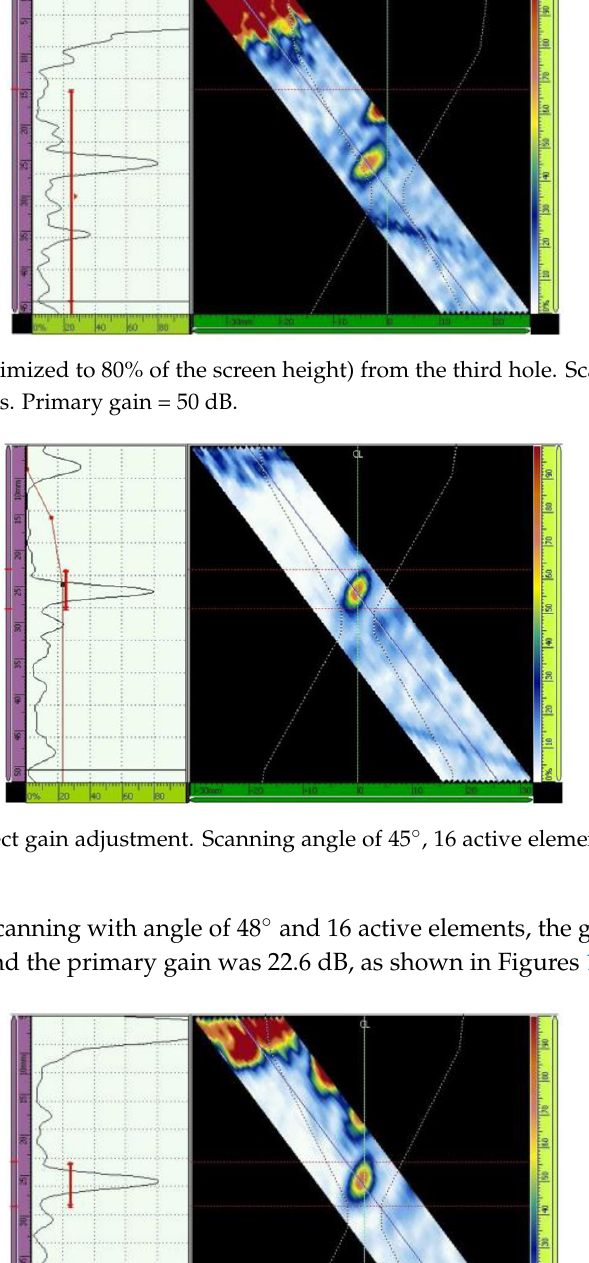
Figure 12. Simulation of sensitivity calibration with longitudinal waves in the calibration block, withdrawn from the 9% Ni quenched and tempered steel pipe joint welded with GTAW and SMAW processes using Ni-based superalloy 625 as the filler metal.